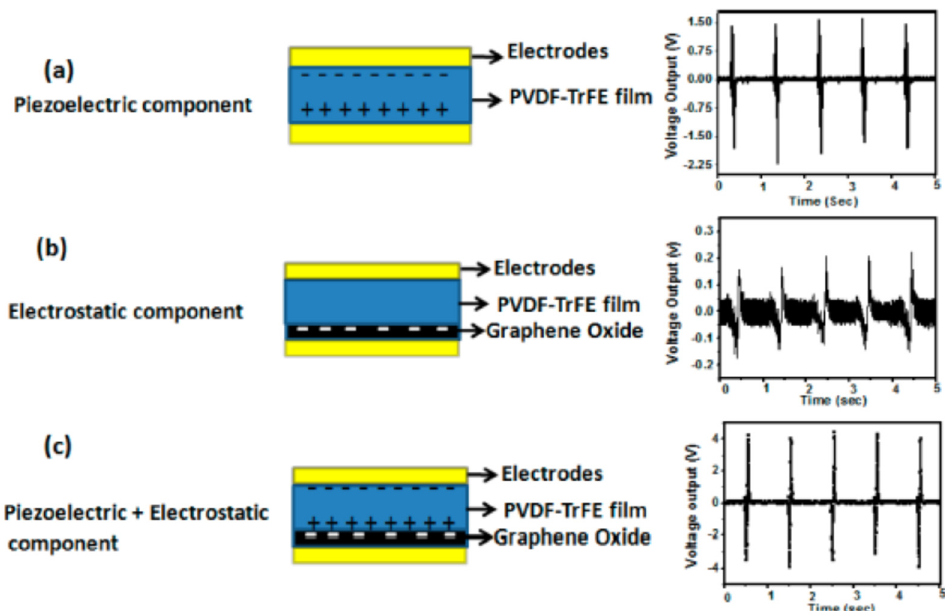
Figure 4. Working mechanism of the bilayer films energy harvesting device: ( a ) piezoelectric voltage output from the poled PVDF-TrFE film; ( b ) electrostatic component (voltage output from the bilayer films, with the nonpoled PVDF-TrFE layer); ( c ) voltage output from the bilayer films device consisting of both electrostatic and piezoelectric components. Reproduced with permission from [17] Copyright 2016 American Chemical Society.